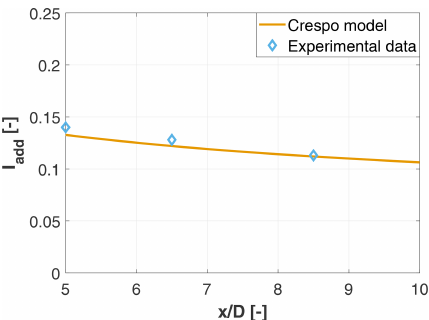
Figure 19. Maximum added TI vs. downstream distance, for the G06 in UTD-HT inflow and the empirical model of Crespo and Hernández